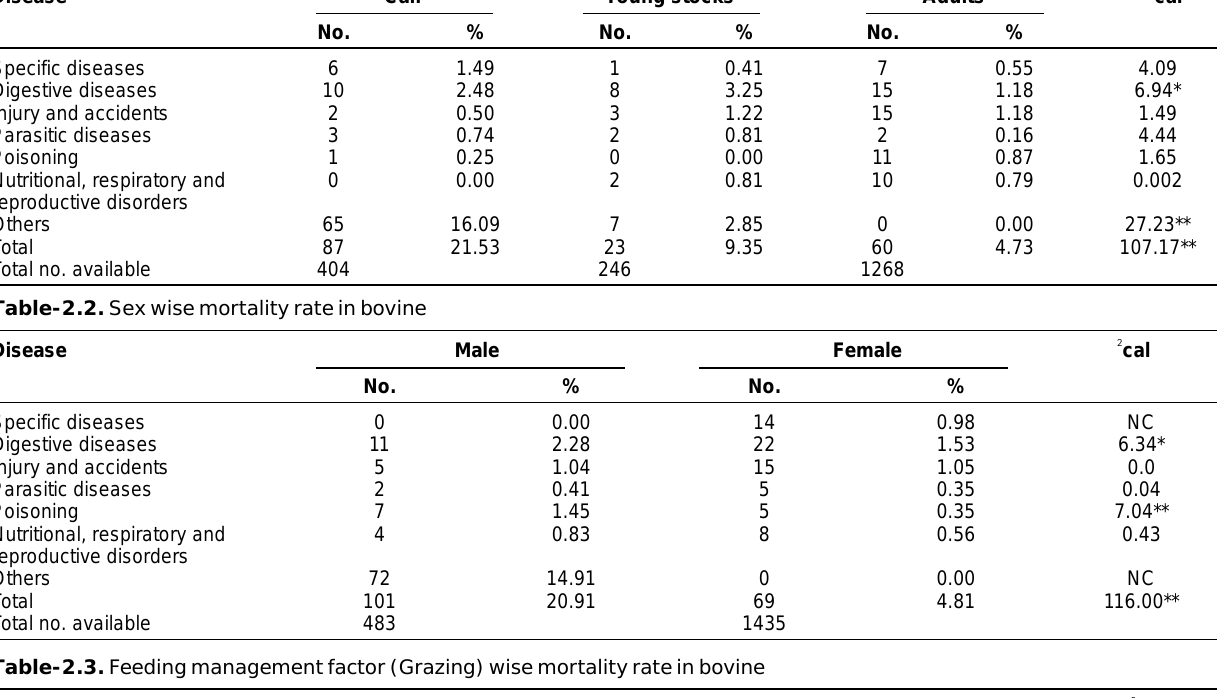
Specific diseases